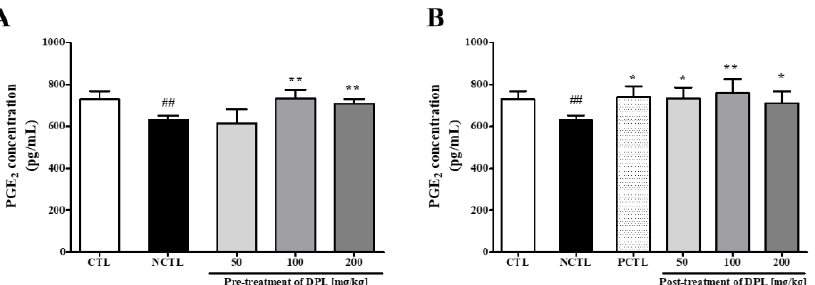
Figure 9. Changes in prostaglandin E2 (PGE 2 ) levels in the colon caused by loperamide administration to rats pretreated with D. morbiferus H. L é v. leaf extract (DPL) ( A ) and post-treated with DPL ( B ). The concentrations of PGE 2 were measured by using enzyme immunoassay (EIA). Each bar represents the mean ± SD for seven mice. ## Significant difference at p < 0.01 compared with the control group (CTL). * Significant difference at p < 0.05 and ** at p < 0.01 compared with the loperamide-induced constipation group (negative control group; NCTL).